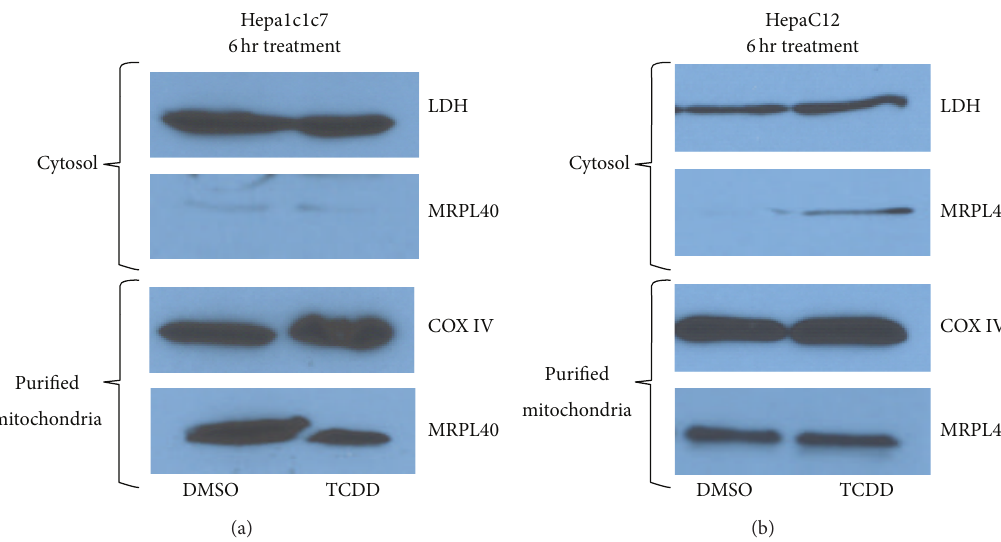
Figure 7: TCDD treatment influences Mrpl40 mitochondrial localization. (a) Cellular fractionation was performed on AHR in wild type Hepa1c1c7 cells. Fractions from cells exposed to TCDD for 6 hours were probed with antibodies specific to MRPL40, lactate dehydrogenase (LDH), and cytochrome c oxidase subunit 4 (COXIV). The results demonstrate a decreased level of mitochondrial localized Mrpl40 following TCDD exposure. (b) Similar cellular fractionations were next performed on AHR null Hepac12 cells. No decrease in Mrpl40 was observed afterexposuretoTCDDfor6hours.LDHwasusedasthecytosolicfractioncontrolproteinandCOXIVwasusedasthepurifiedmitochondrial fraction control